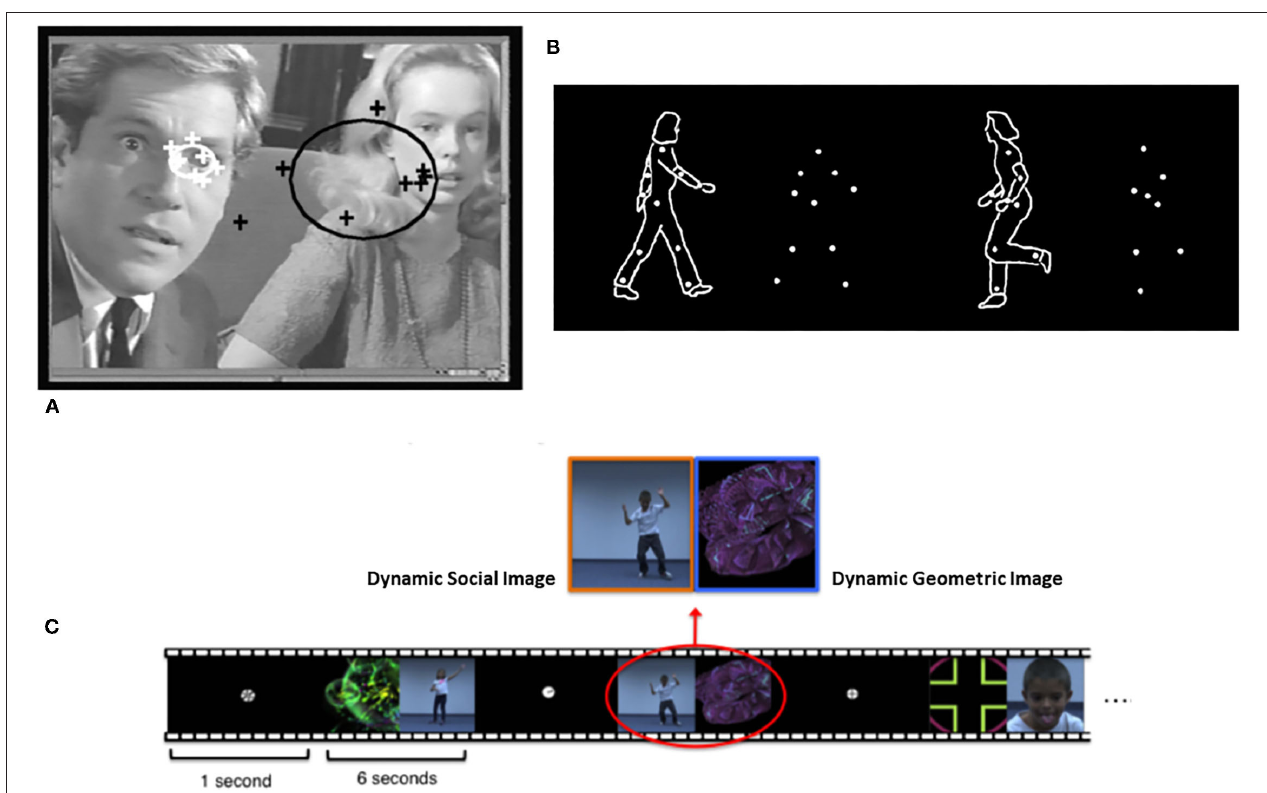
FIGURE 1 | Illustrations of (A) eye-tracking, (B) biological motion, and (C) paired-preference measures of social-orienting from Klin et al. (11), Pierce et al. (12), and Puce and Perrett (13), respectively. Figures reprinted with permissions from, a) Nature, Springer Nature, b) Philosophical Transactions. Biological Sciences, Royal Society, and c) Biological Psychiatry, Science Direct,